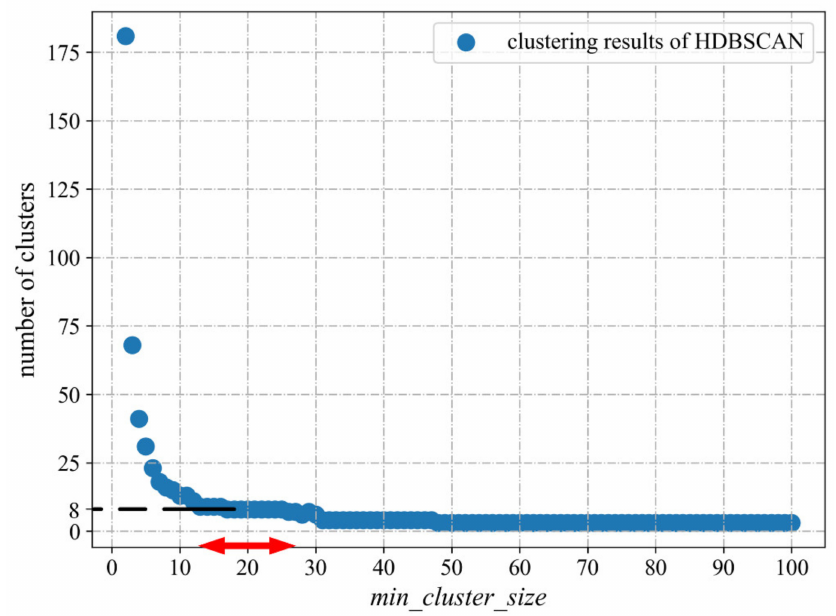
Figure 15. The connection between the minimum cluster and the number of